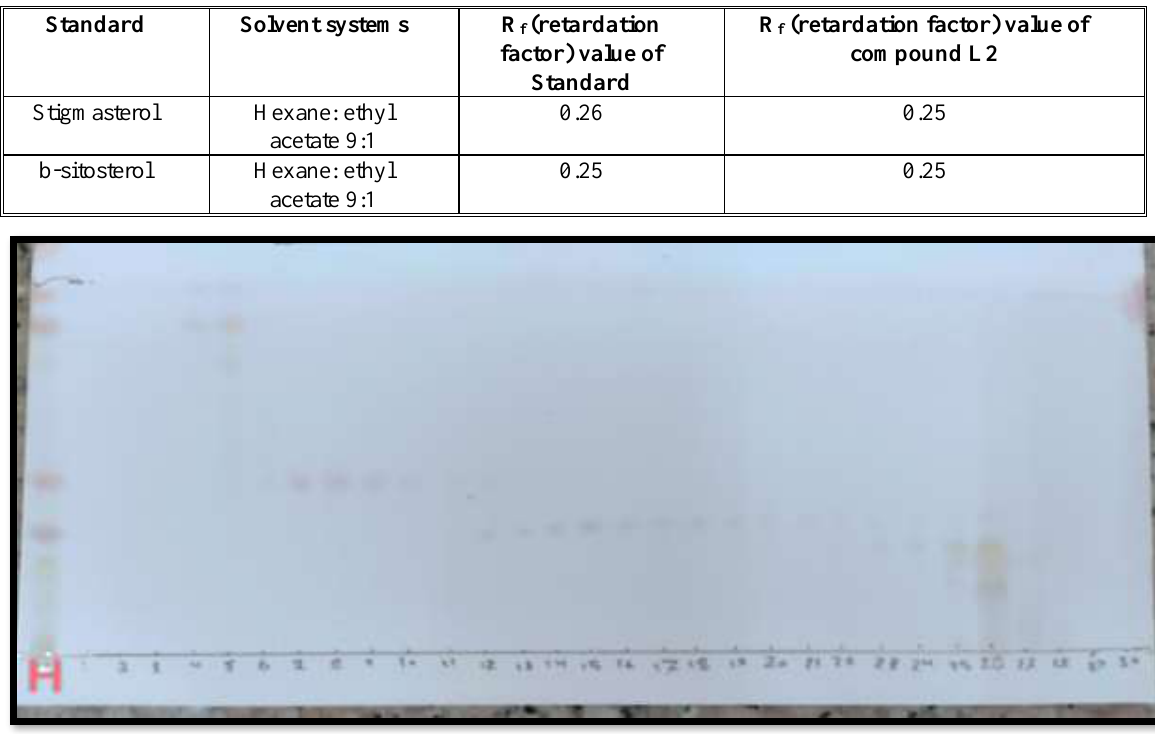
Figure 2. Thin layer chromatogram for Hexane fraction(h) with beta-sitosterol(b) and stigma sterol(s) std. Using silica gel GF 254nm as a stationary phase developed in Hexane: ethyl acetate 9:1 as mobile phase. They were visualized by 5% H2SO4 spray reagent followed by heating for 5-10 minutes at 110 C°. Table 2. R f value of phytosterol obtained from hexane fraction of Iraqi Lactuca serriola compared to stigmasterol and b-sitosterol standard .